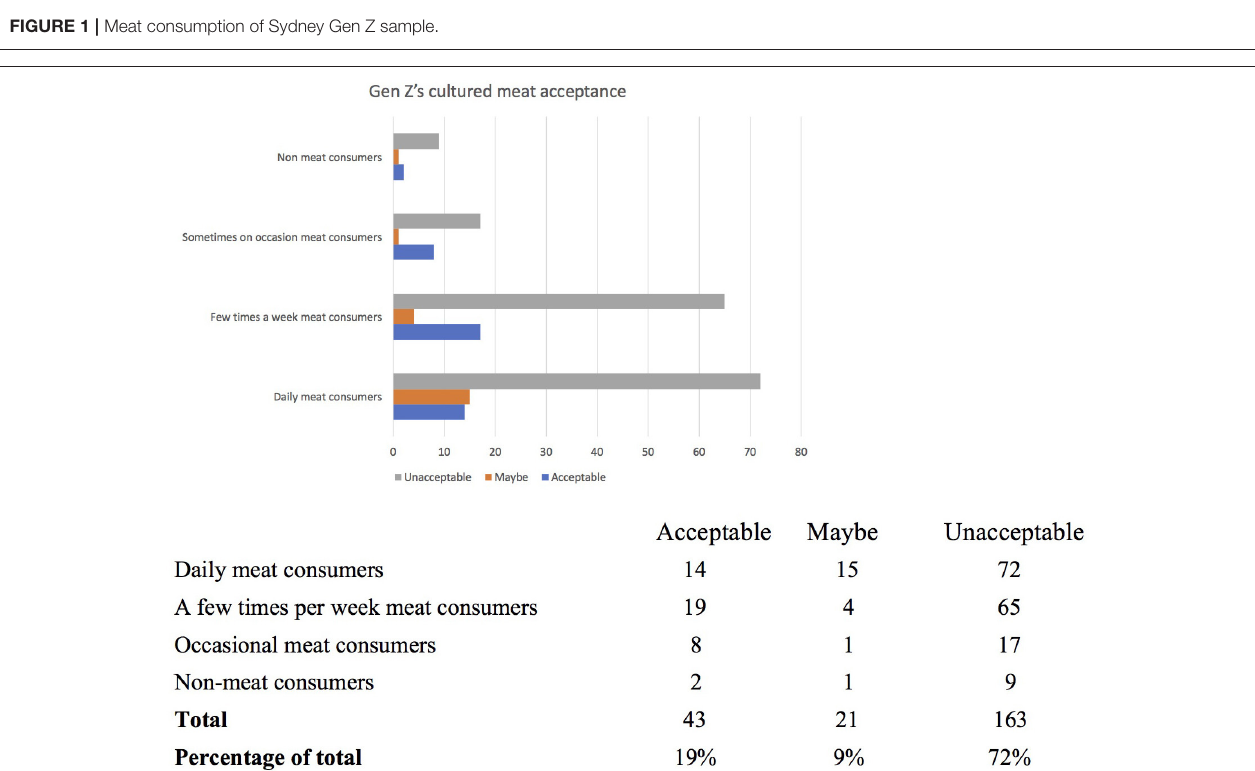
FIGURE 2 | Acceptance of cultured meat by Sydney Gen